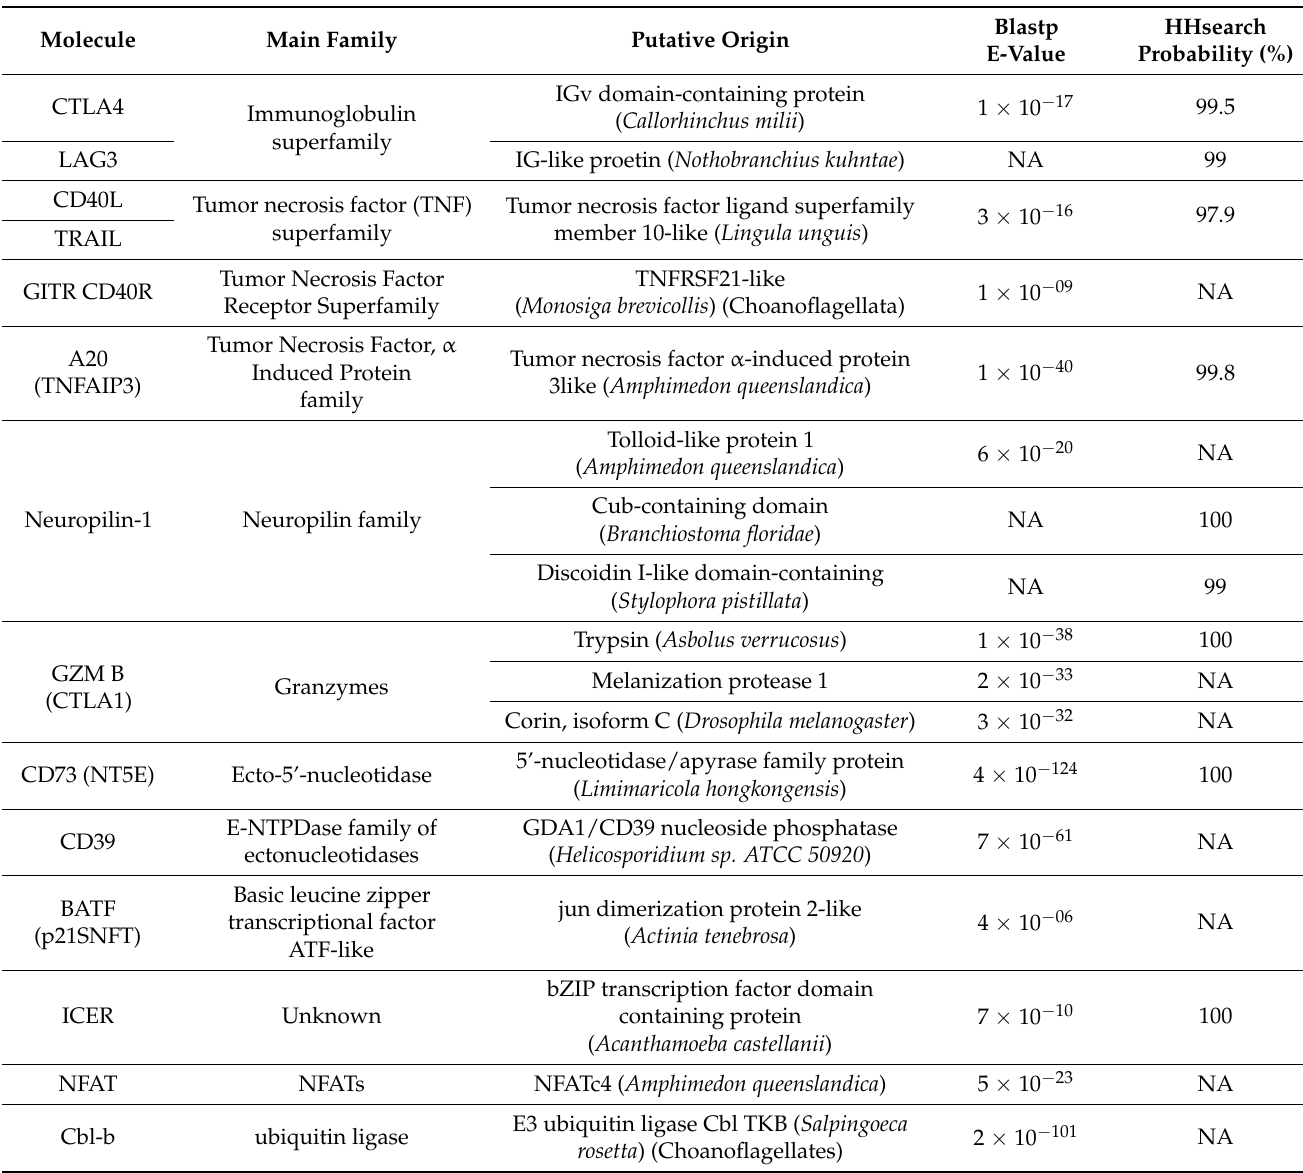
Table 3. Putative origins for Treg-mediated